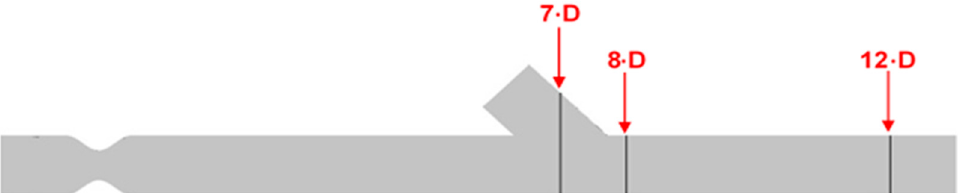
Figure 11. Identification of the cross sections for computational result presentation along with the artery